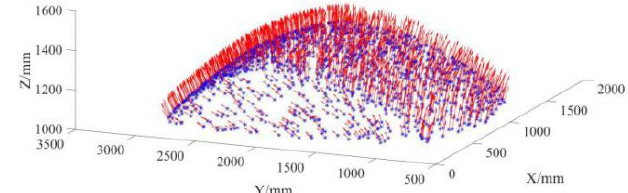
Figure 23. Normal vectors of target trajectory points.